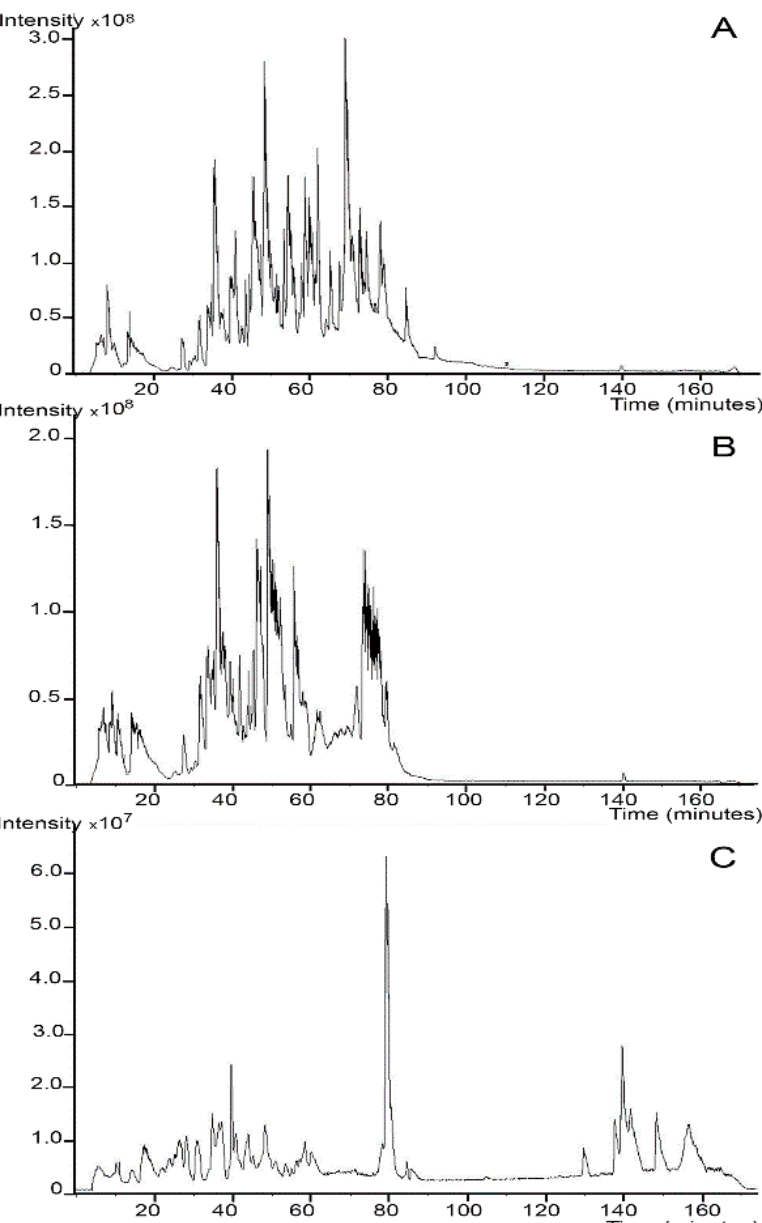
Figure 1. Comparison of mass spectrometry (MS) profiles (i.e., extracted ion chromatograms) of native protein mixture and tissue surrogate extracts. Formalin-fixed paraffin-embedded (FFPE) tissues were heated in 50 mM Tris, pH 8 and 2% SDS at either elevated (40,000 psi) or atmospheric (14.7 psi) pressure. The extracts were analyzed using liquid chromatography (LC)/MS. The MS profiles of each FFPE extract were compared to the native, unfixed protein mixture. ( A ) native, unfixed tissue surrogate mixture; ( B ) FFPE tissue surrogate extracted at 40,000 psi; ( C ) FFPE tissue surrogate extracted at 14.7 psi, adapted with permission from ref.